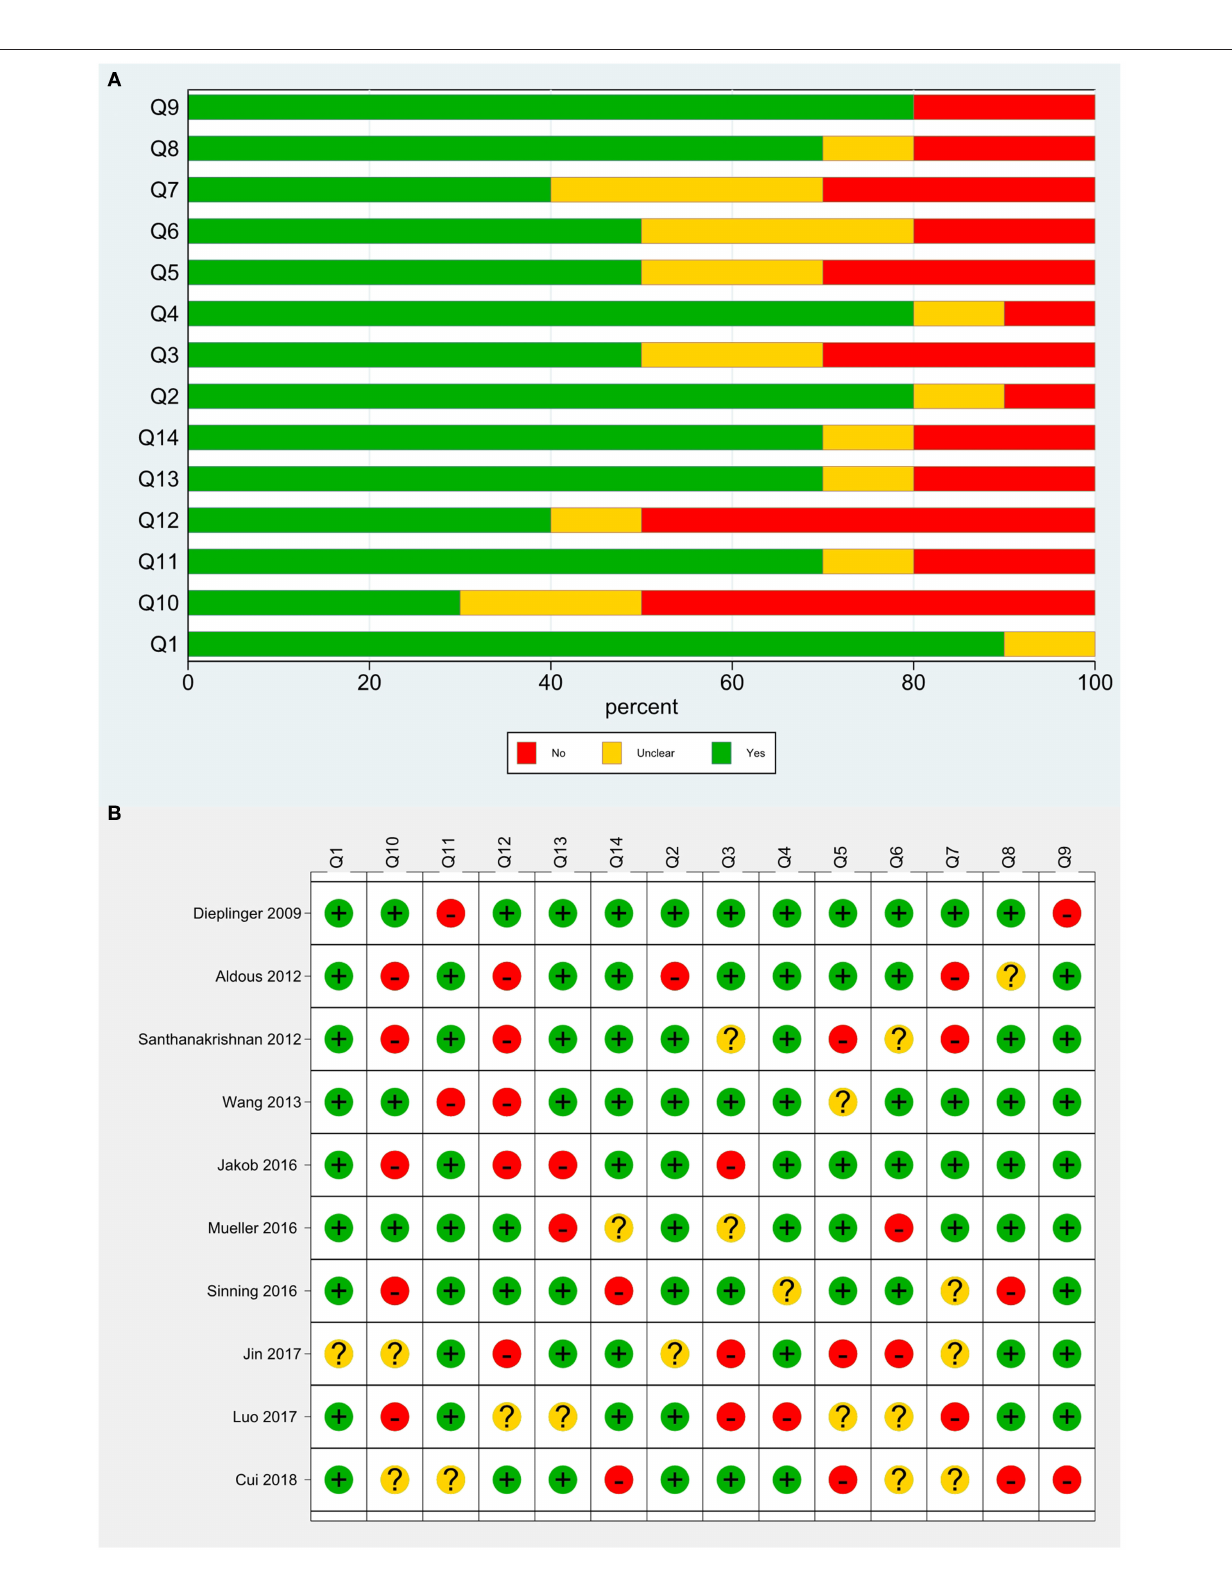
Frontiers in Cardiovascular Medicine |